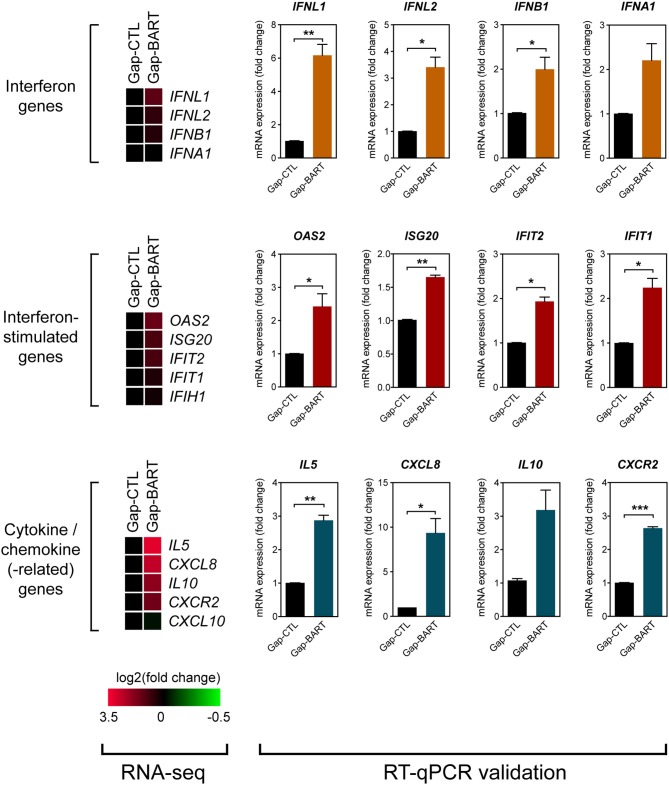
Targeting BART lncRNA affects immune-related gene expression. Differential expression of various interferon, interferon-stimulated, cytokine and chemokine genes not fitting the RNA-seq analysis criteria (>2-fold up- or down-regulation, 0.1 FDR) was analyzed by RT-qPCR. Gene expression is shown as fold change in mRNA expression relative to that of GAPDH. Results represent the average and SEM of three independent experiments. *P < 0.05, **P < 0.01, ***P < 0.001.